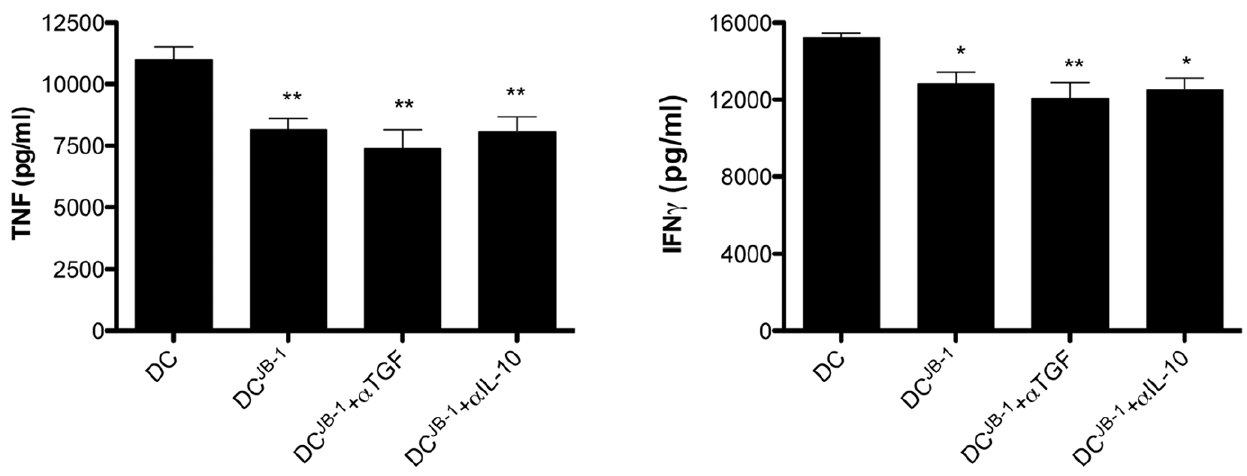
Figure 8. Blocking IL-10 or TGF b does not prevent the suppression of T cell inflammatory cytokine production by JB-1 exposed DC. Isolated mesenteric CD11c + DC were co-cultured with L. rhamnosus JB-1 at a ratio of 10:1/bacteria:DC, for 2 h at 37 u C and incubated with purified CD4 + CD25– responder T cells from DO11.10 transgenic mice for 5 days. T cells were harvested and stimulated by antibodies against CD3/CD28 in the presence of OVA protein for 48 hr and the supernatants analyzed for cytokine production. Where indicated, anti-IL-10 (1 m g/ml) or anti-TGF b (50 m g/ ml) was added to the co-culture. Data is presented as mean values 6 SEM n=5, *p , 0.05 compared to control values.